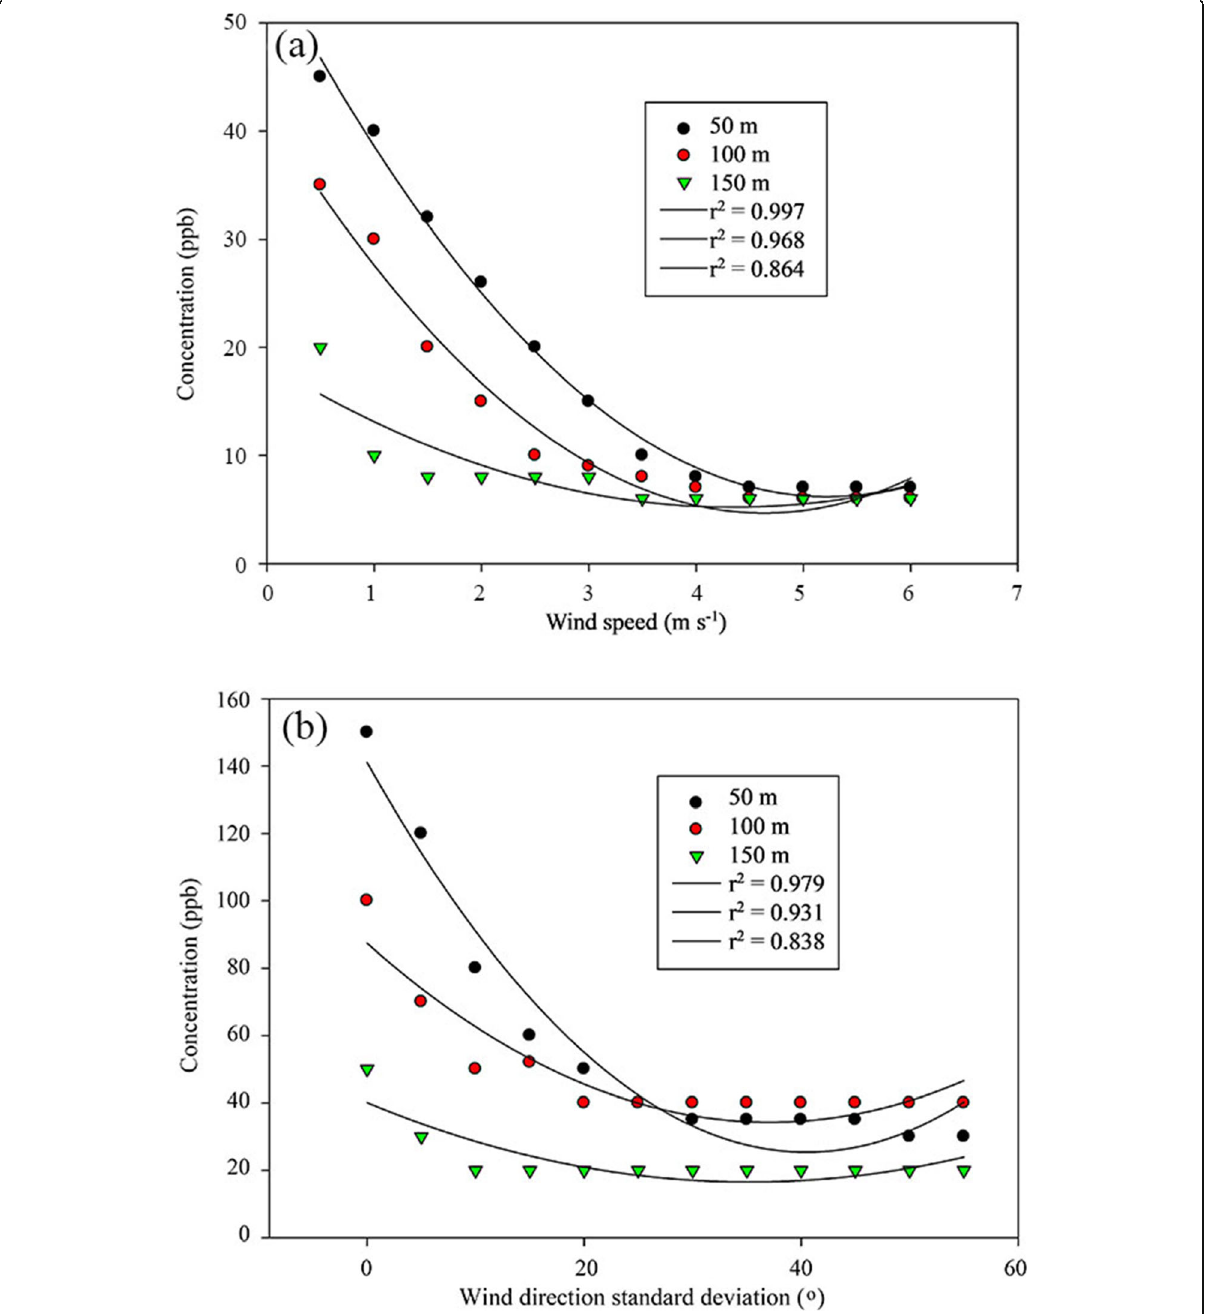
Fig. 11 a Relationship between wind speed and CO concentration; b the relationship between wind direction standard deviation and CO